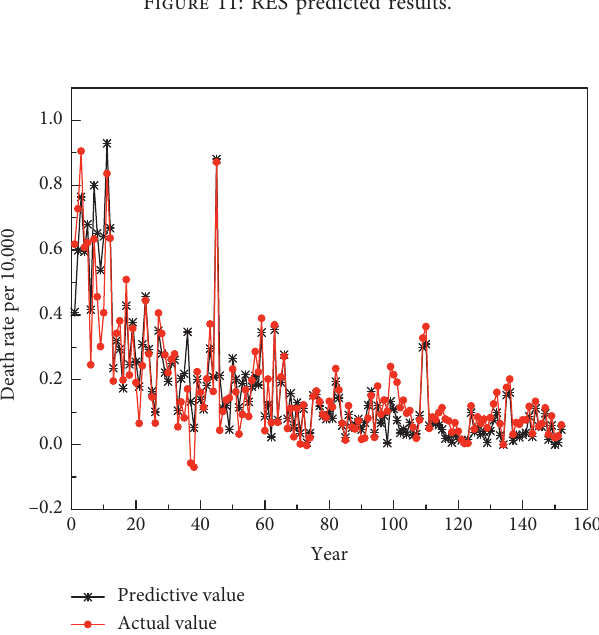
Figure 11: RES predicted results.